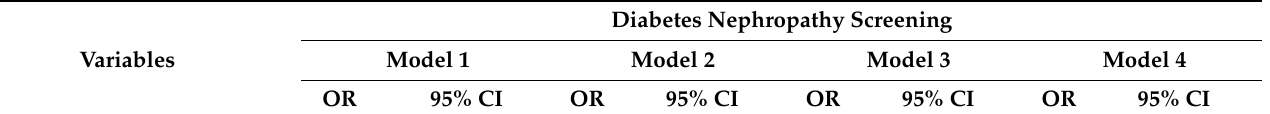
Table 3. Adjusted odds ratios of diabetes nephropathy screening by characteristics of an individual- and area-level, multilevel